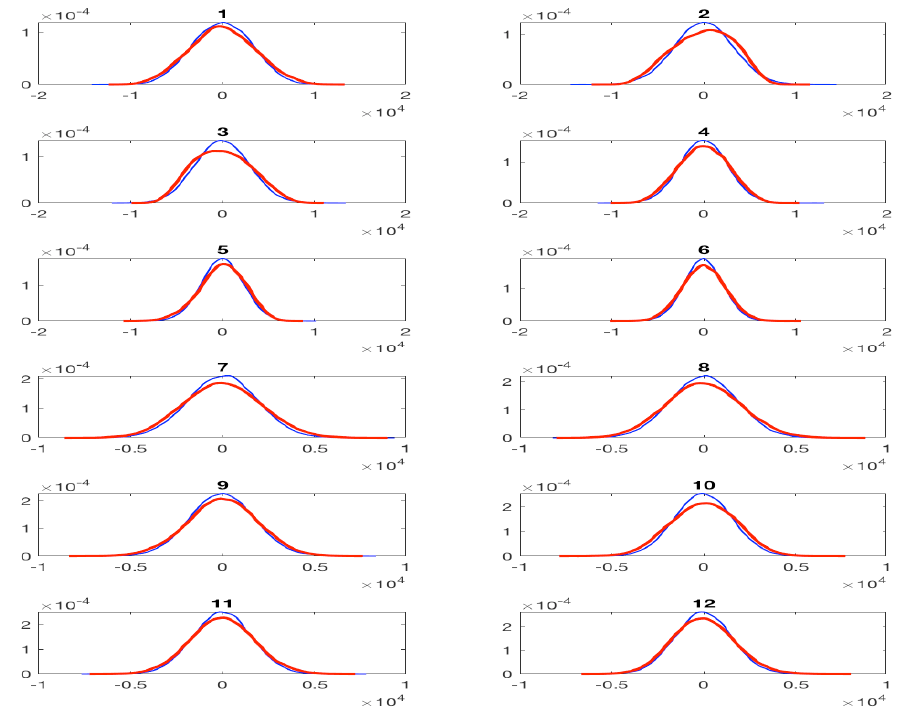
Figure A5. Same format as in Figure A7, but the comparison of harmonic reconstruction (red) and